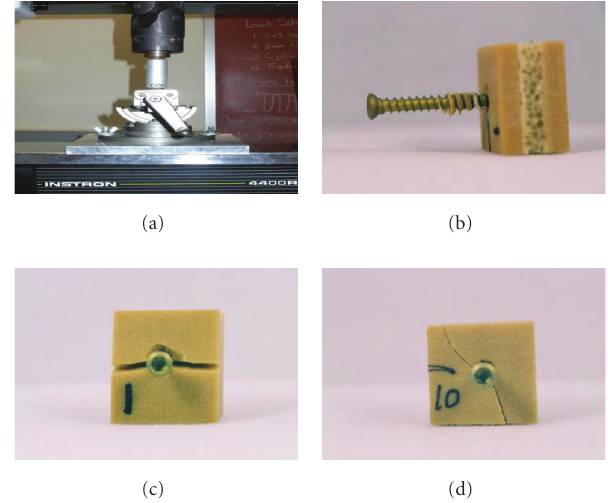
Figure 1: (a) Experimental setup for the pull-out tests, (b) typical specimen after cylindrical failure with material trapped between screw threads, (c) pull-out specimen with vertical cracks, and (d) pull-out specimen with diagonal cracks.